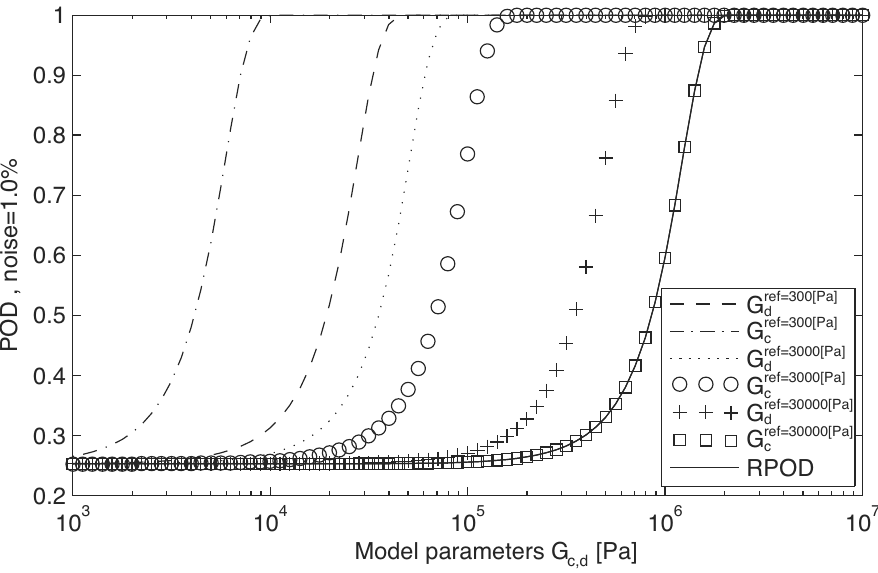
Figure 6. RPOD evaluation (Step 7) of phase 2, for different shear modulus values of